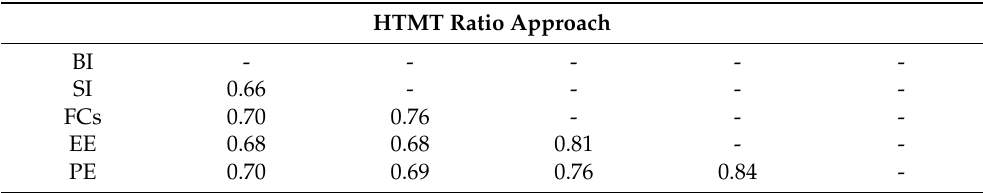
Table 7. Discriminant